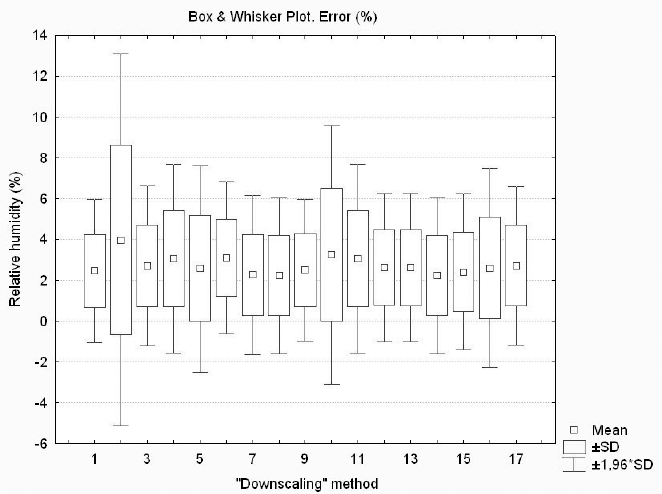
Figure 3. Estimated mean absolute errors (MAE) for relative humidity using different deterministic and geostatistical methods. The 17 methods used were: (1) Global Polynomial Interpolation; (2) Inverse Distance Weighting; (3) Local Polynomial Interpolation; (4) Kriging; (5) Cokriging (altitude, aspect); (6) Cokriging (altitude); (7) Cokriging (altitude, slope, wind speed); (8) Cokriging (altitude, slope); (9) Cokriging (altitude, slope, aspect); (10) Radial Basis Functions; (11) Cokriging (altitude, slope, canopy cover); (12) Cokriging (altitude, slope, forest area); (13) Cokriging (altitude, aspect, forest area); (14) Cokriging (altitude, slope, wind direction); (15) Cokriging (altitude, slope, valley bottom); (16) Cokriging (slope, aspect); (17) Cokriging (altitude, slope,